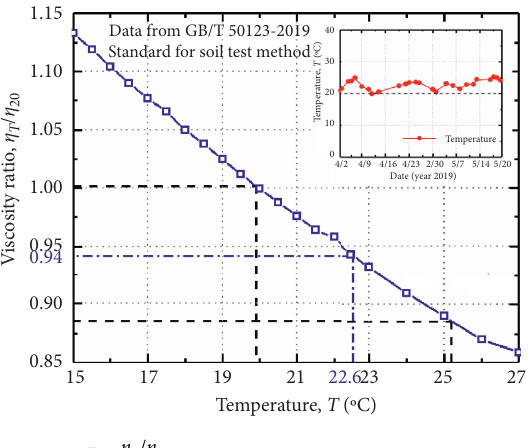
Figure 2: Viscosity ratio for pure water at various temperatures (based on the standard for soil test method GB/T 50123-2019).